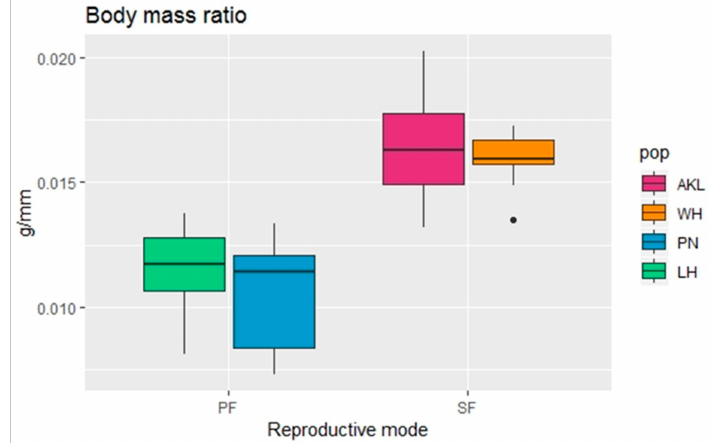
Figure 7. Comparison of the body mass ratio (body mass / body length; g / mm) between females of the stick insect Clitarchus hookeri with di ff erent reproductive modes (SF = sexual females, PF = parthenogenetic females) and populations (pop; AKL = Auckland, WH = Whanganui, PN = Palmerston North, LH = Lower Hutt). The ends of each box represent the upper and lower quartiles, the median is marked by the vertical line inside the box. The whiskers show the highest and lowest observations, and the black points indicate